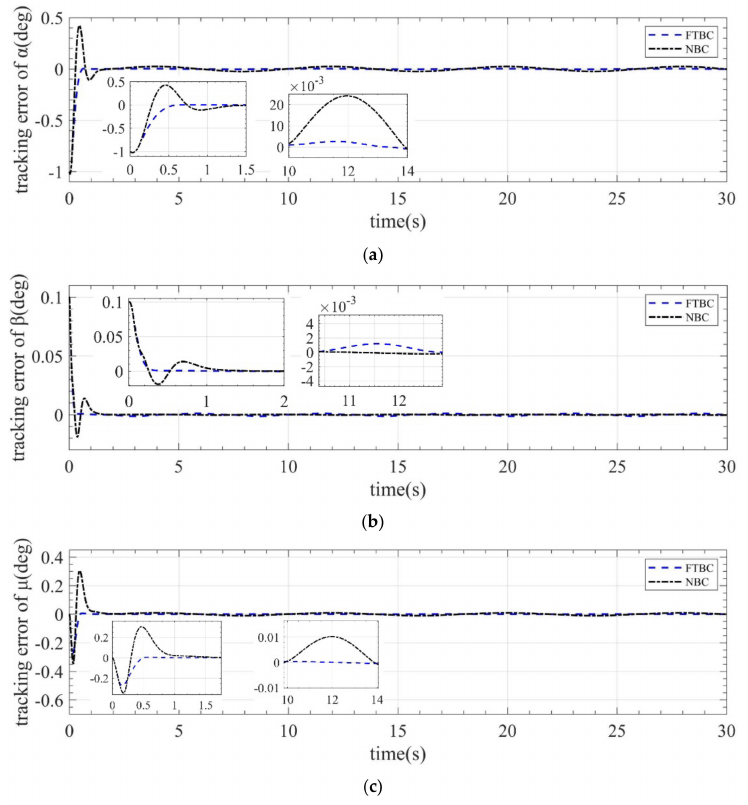
Figure 11. ( a ) Tracking error curve of e α , ( b ) tracking error curve of e β , and ( c ) tracking error curve of e µ .